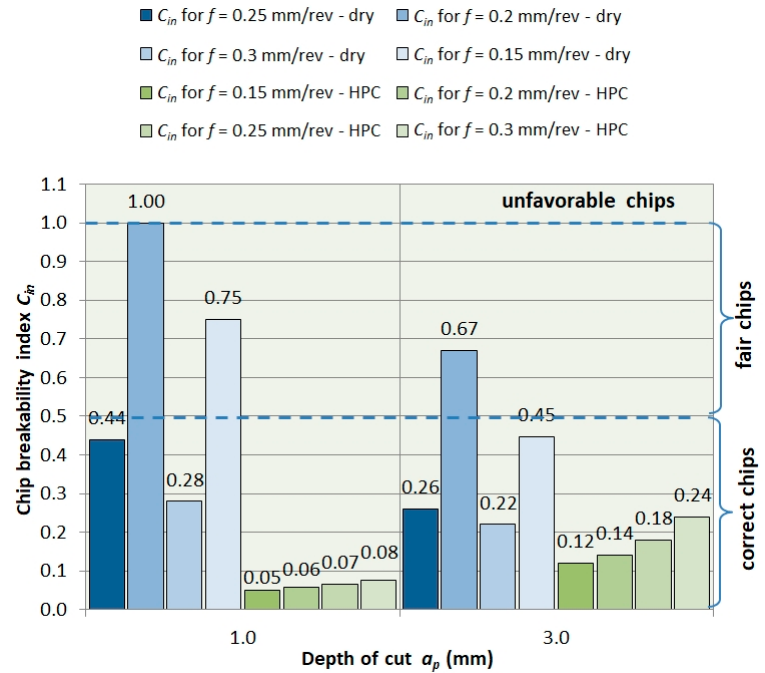
Figure 10. Dependence of the chip breaking index ( C in ) from the cutting depth a p .